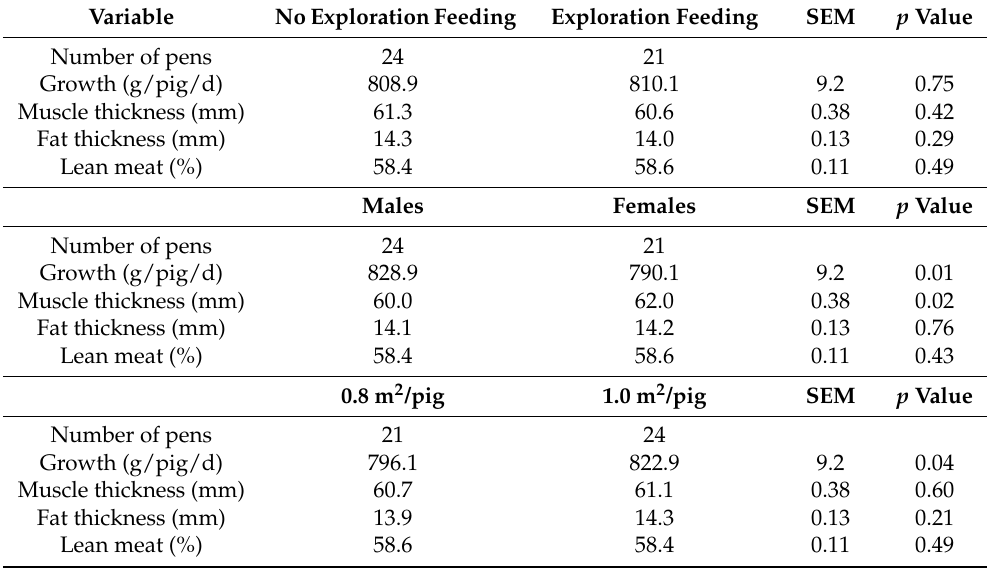
Table 4. Mean performance data per main treatment factor with SEM and p